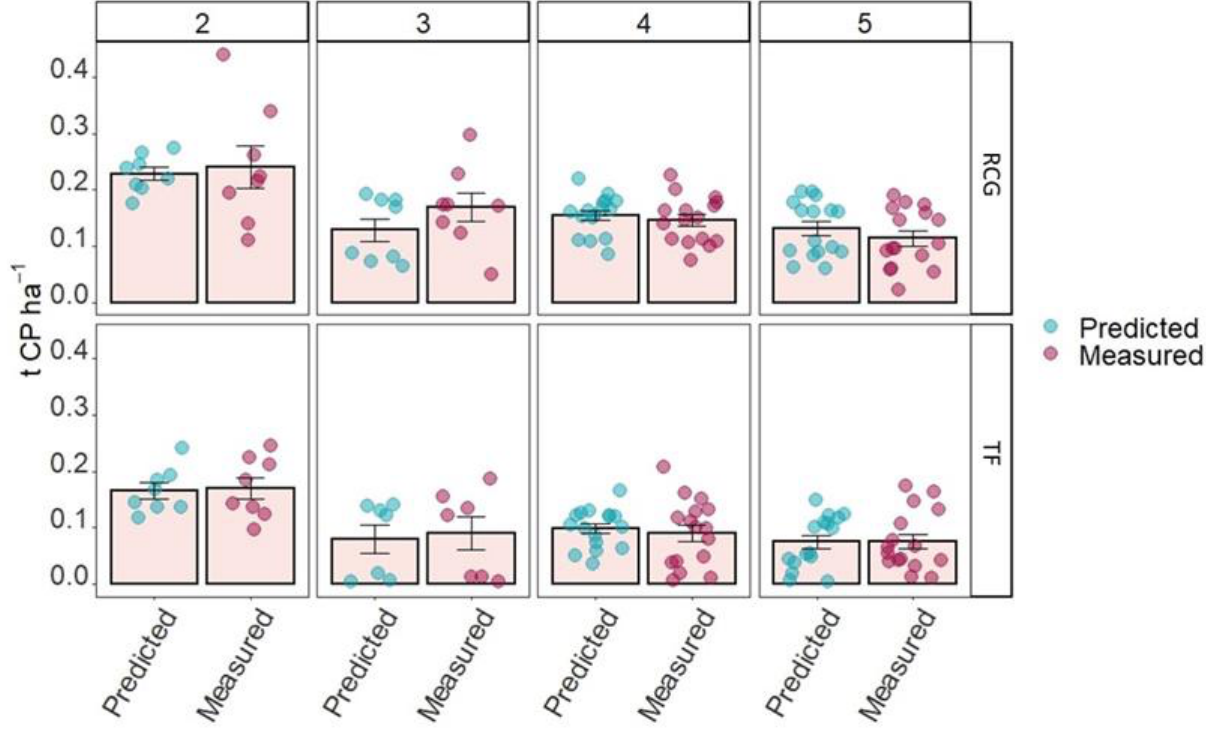
Figure 4. Model derived (Predicted) and actual (Measured) values of crude protein (CP; t ha -1 ) in protein precipitate across harvest frequencies of one to five occurrences per year, for Phalaris arundinacea (RCG) and Festuca arundinacea (TF). The (pink) columns represent mean values and the error bars show standard error. Dots indicate the individual